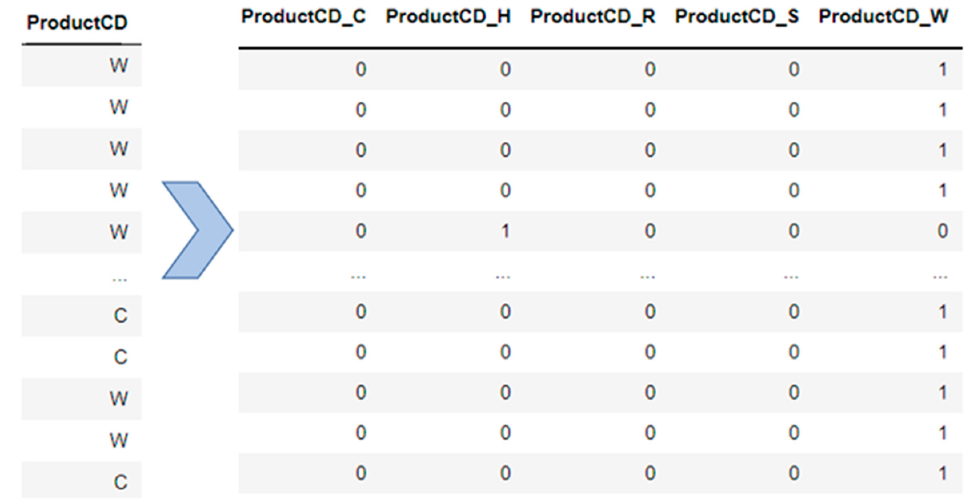
Figure 3. One-hot encoding.